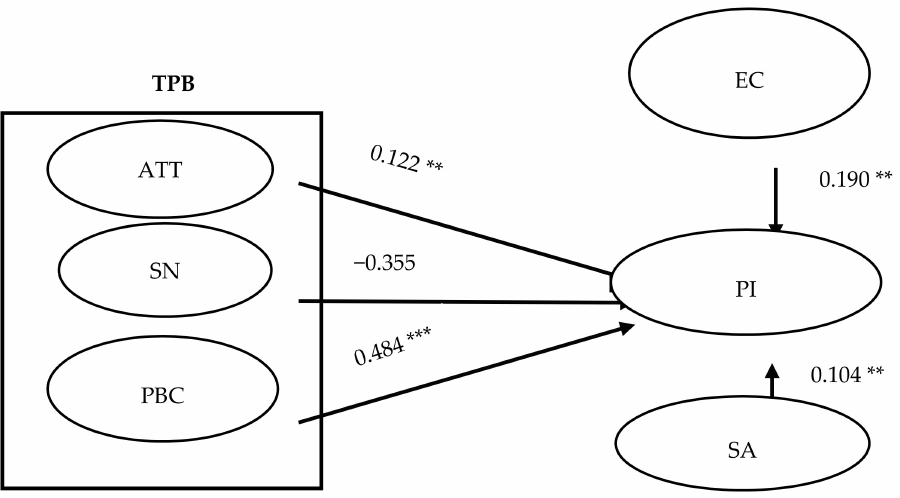
Figure 3. Results of SEM. ** p < 0.01; *** p < 0.001; GFI = 0.935; AGFI = 0.891; TLI = 0.981; CFI = 0.986; RMSEA =